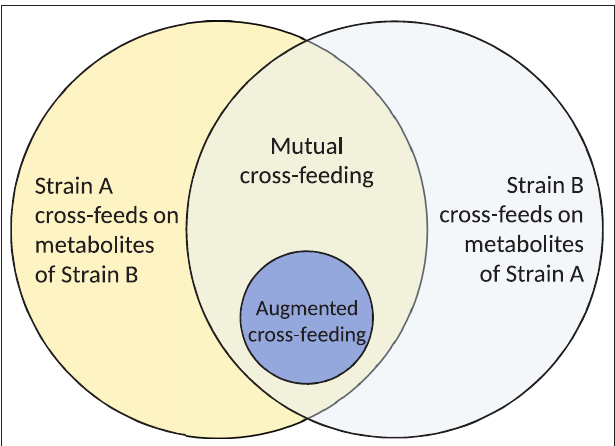
FIGURE 2 | A Venn diagram illustrating the nature of mutual and augmented cross-feeding. Mutual cross-feeding requires that each strain is cross-feeding on products produced in the metabolism of the other. Each partner must be engaged in metabolite and/or substrate cross-feeding. Augmented cross-feeding relationships form a subset of mutual cross-feeding